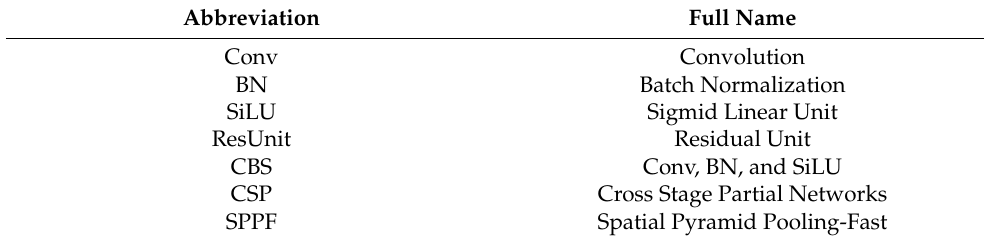
Table 2. The abbreviations and corresponding full name in Figure